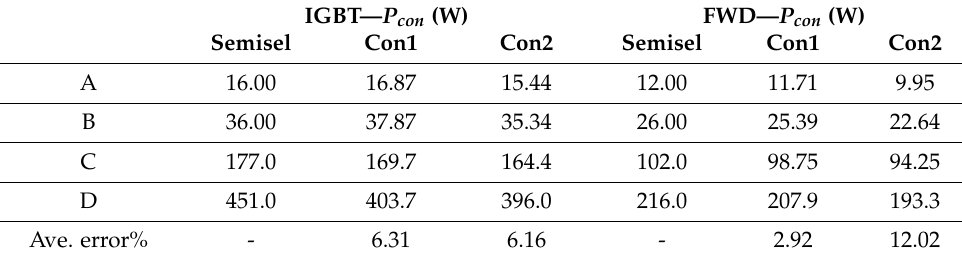
Table 13. Conduction losses comparison, V DC = 700